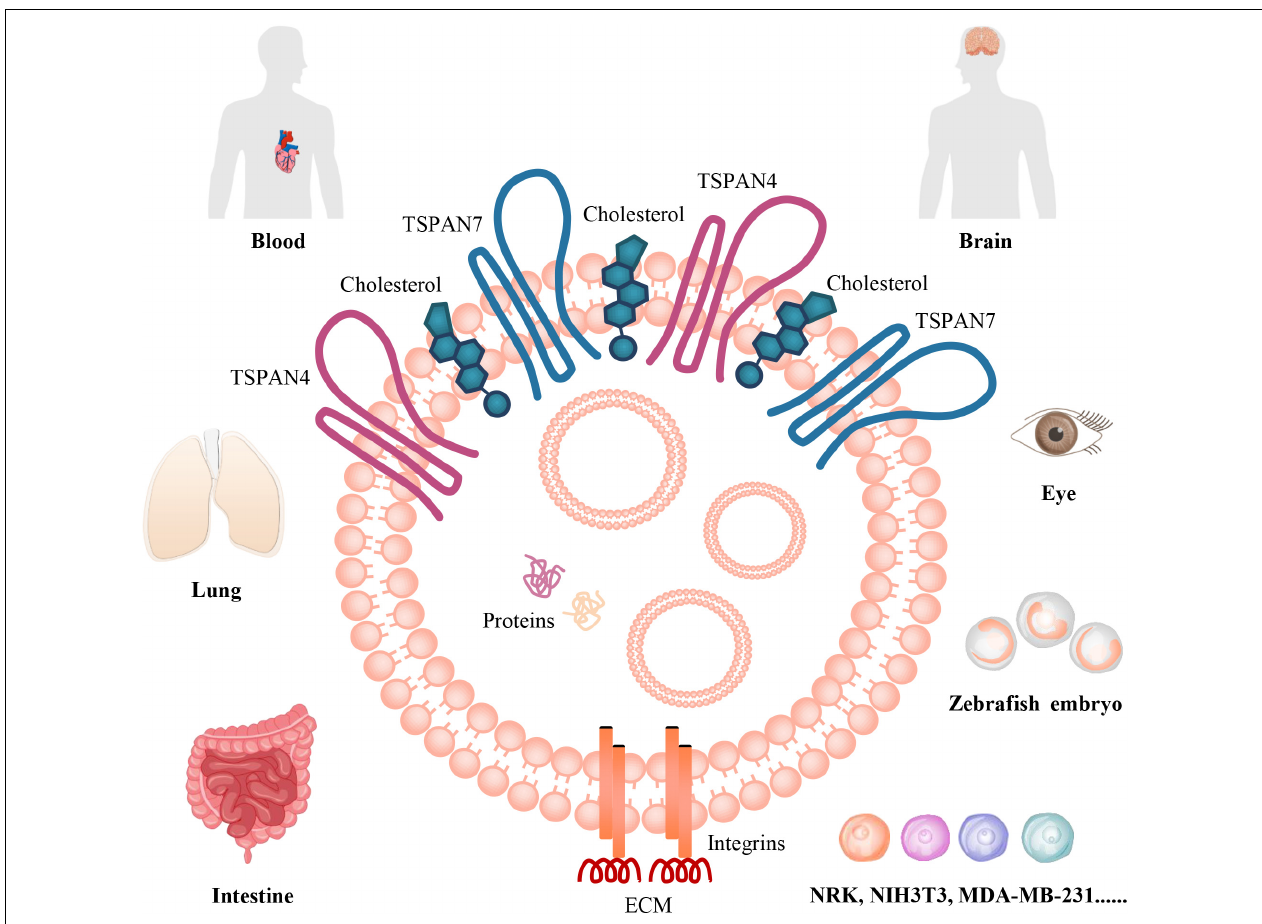
FIGURE 1 | The organization and distributions of migrasomes. Migrasome, which is an extracellular membrane-bound vesicular structure and includes cytosolic proteins and small vesicles in the cavity, is organized by TSPANs, cholesterol, and integrins. The matching of specific integrin-ECM pairs determine when and where migrasome can be generated in vivo . They are distributed in human blood and stroke specimens; in mouse brain and eye, rat lung, rat/mouse intestine; in zebrafish embryo. They are also found in numerous cancer cells, such as MDA-MB-231, SKOV-3, HCT116, SW480, MGC803, B16; in normal rat or mouse cells, including NRK, NIH3T3, mouse embryonic stem cells, hippocampal neurons and bone marrow-derived macrophages, and microglia; and in HaCaT in vitro